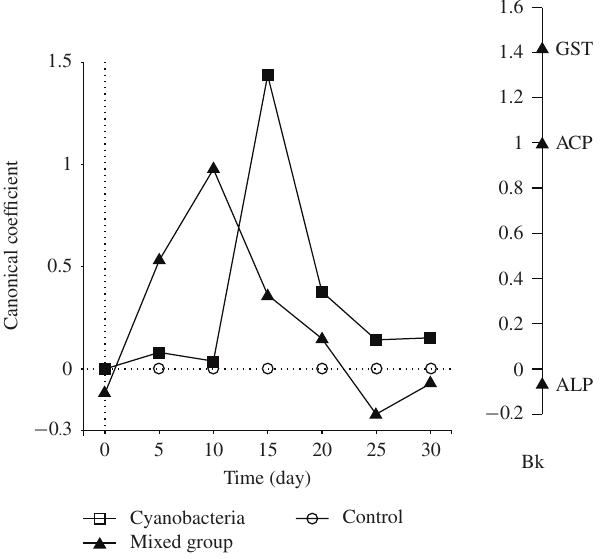
FIGURE 1: Principal response curve (PRC) of enzyme activity in the snails under different treatments (control, mixed group, cyanobacteria group) at seven sampling events (0, 5, 10, 15, 20, 25, and 30 days after the beginning of the experiment). Bk indicates the weight of biochemical parameters measured: glutathione S-transferases (GST), acid phosphatase (ACP), and alkaline phosphatase